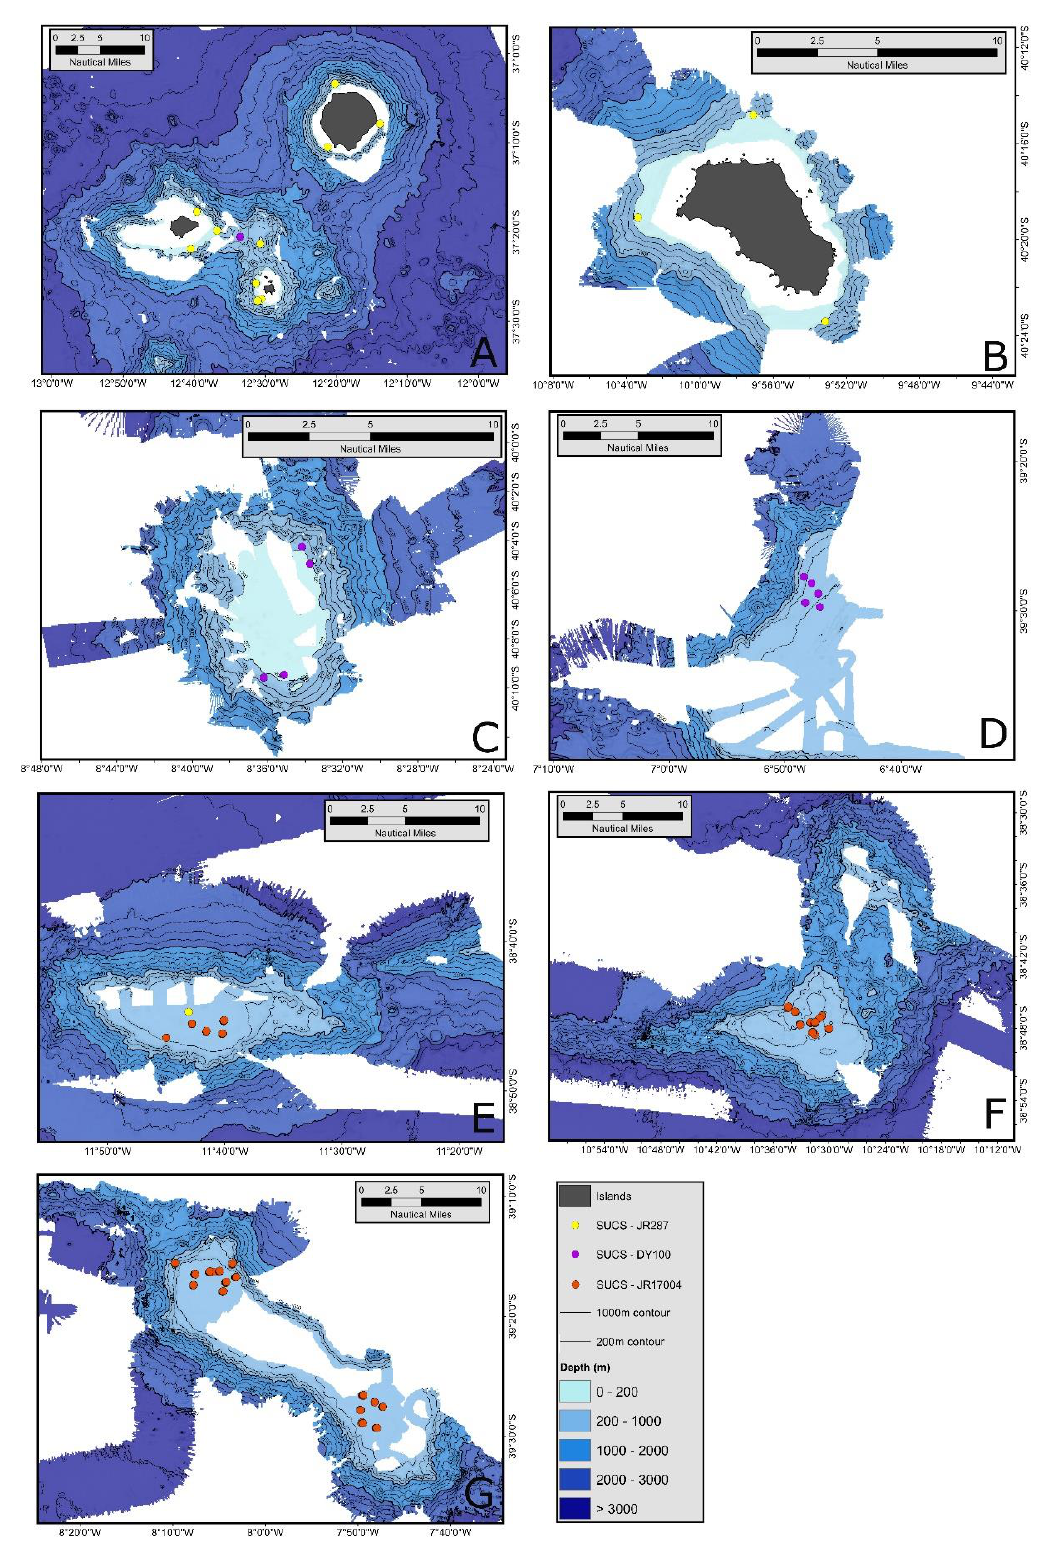
Figure 2. Seabed mapping and camera sites around the islands and seamounts of the Tristan da Cunha archipelago. Scale bars, depths, samples and research cruise origin of data collection are shown for each island/seamount group. The locations are Tristan da Cunha northern islands ( A ), Gough Island ( B ) and seamounts McNish ( C ), RSA ( D ), Esk ( E ), Crawford ( F ) and Yakhont ( G